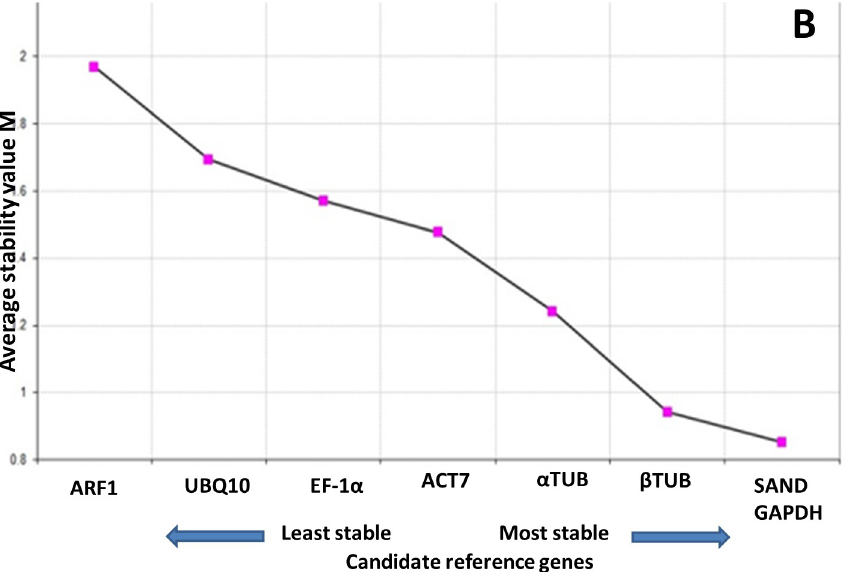
Fig 9. Gene expression stability values (M). Ranking of the gene expression stability performed in A . tumefacians mediated transiently transformed leaves.